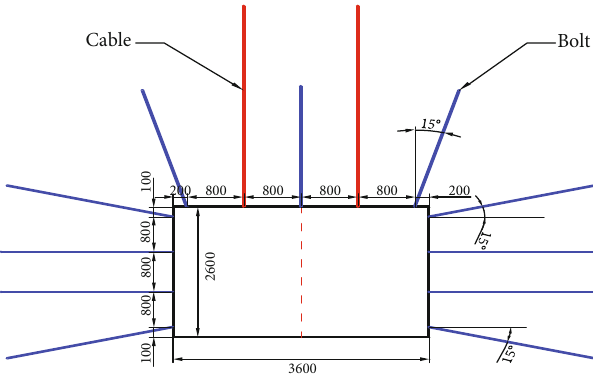
Figure 15: Roadway support scheme.